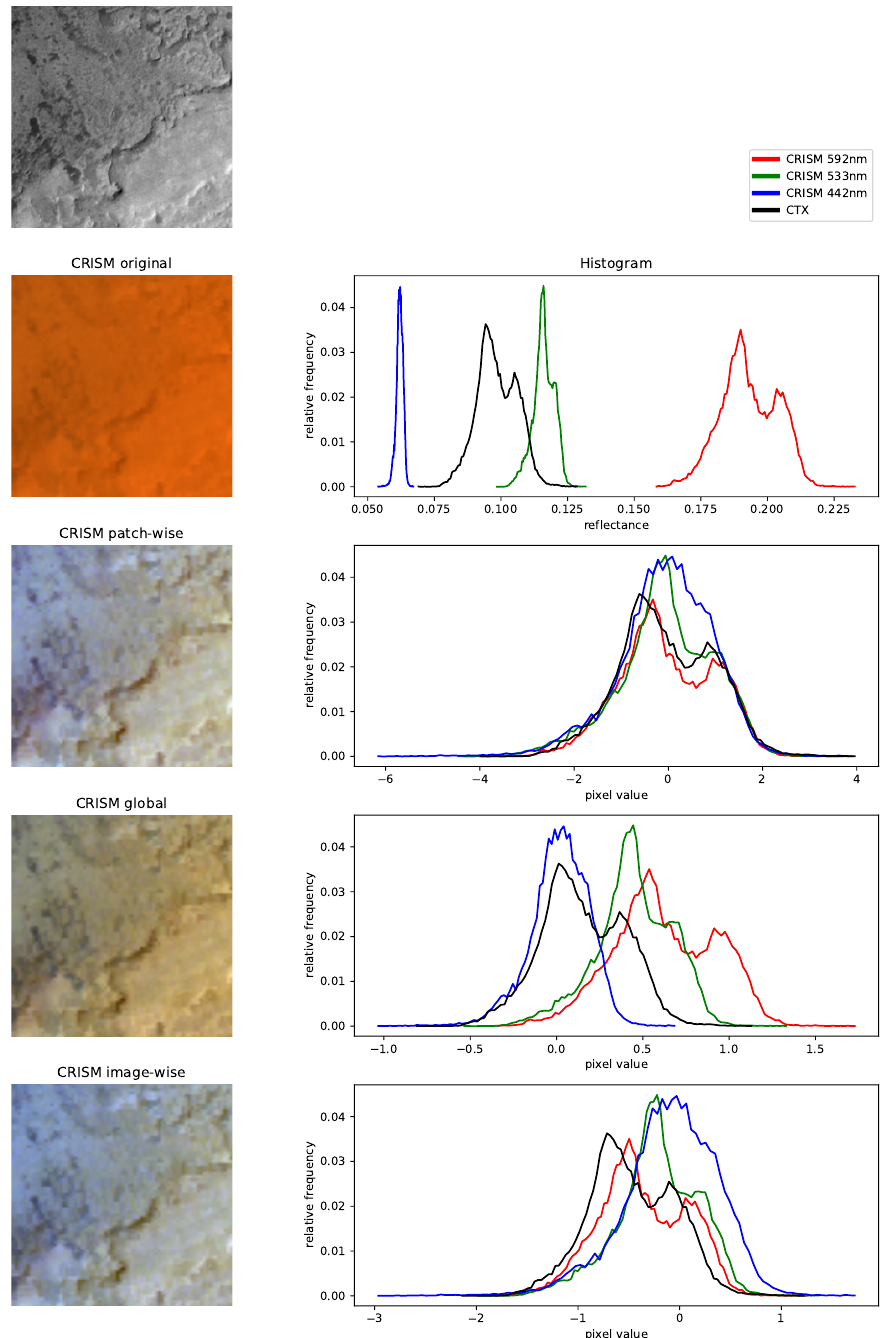
Figure A3. Impact of different normalization methods on the appearance ( left ) and distribution of pixel values ( right ) for one exemplary 256 by 256-pixel EVC CRISM and CTX